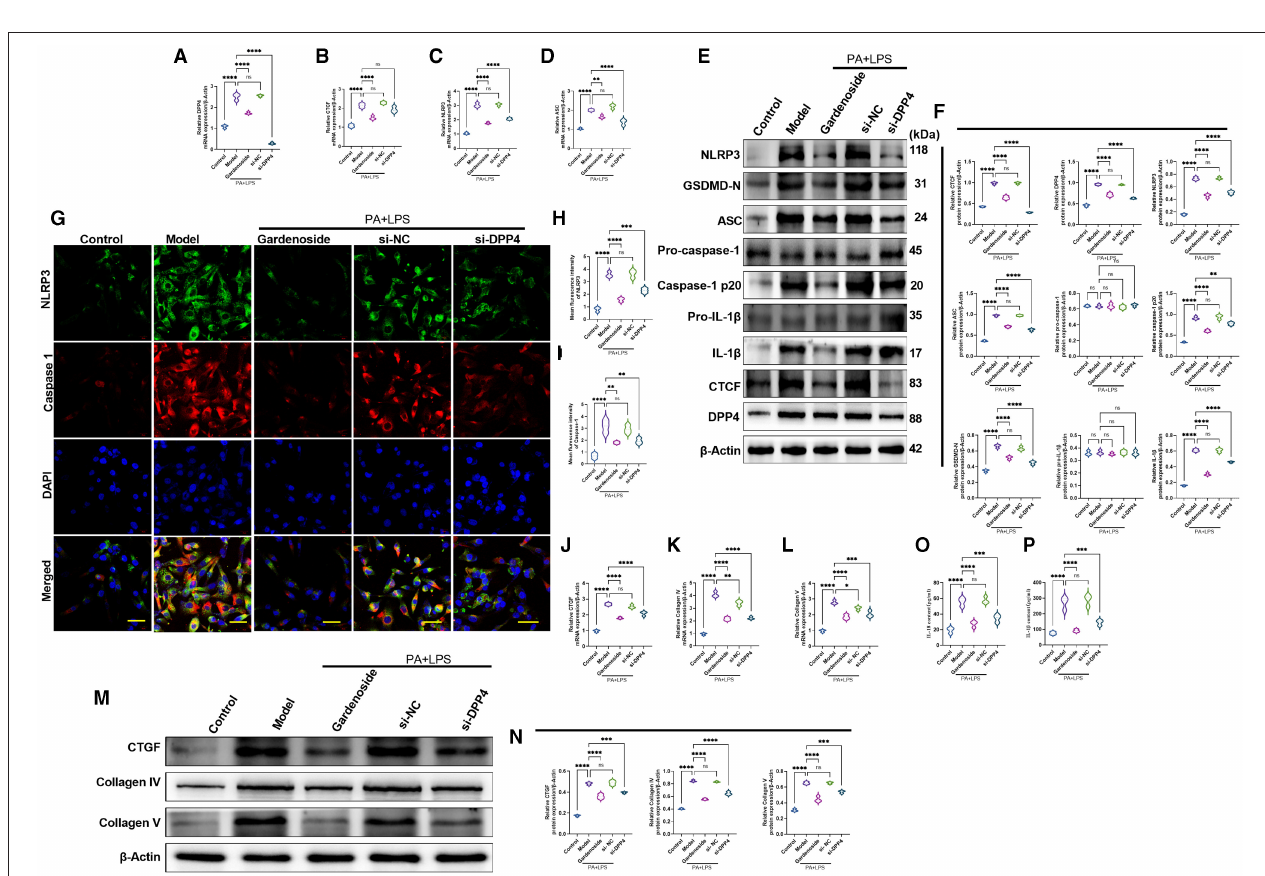
FIGURE 7 | (C) Detection of LDH release in AML cells of indicated groups. (D) Detection of intracellular ROS production in AML cells of indicated groups. (E) Detection of cell apoptosis by Hoechst/PI staining of AML cells of indicated groups (scale bar: 50 µ m). (F) Representative flow cytometry images indicating the levels of apoptosis and pyroptosis of AML cells in different treatment groups. (G) Quantitative representation of pyroptosis rate of AML cells in different treatment groups as detected by flow cytometry. (H) Quantitative representation of apoptosis rate of AML cells in different treatment groups as detected by flow cytometry. ns,